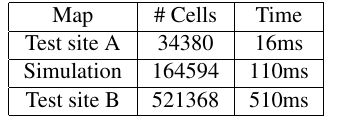
Table 1. The computation time results of the algorithm. The left column shows the point cloud used, the middle column the number of cells in the height map and the right column the computation time for building the height map and classifying the cells.